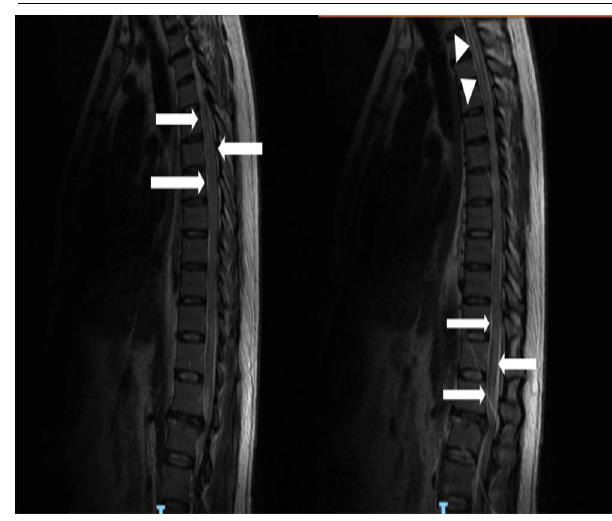
Figure 2 . Magnetic Resonance